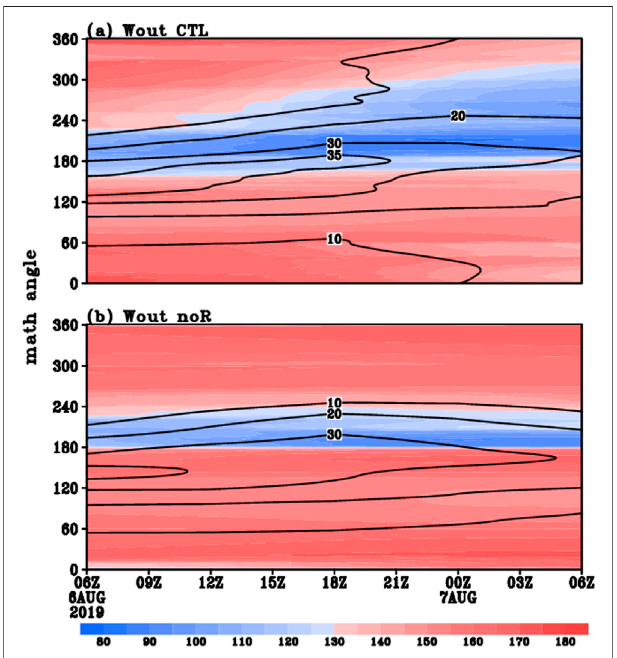
FIGURE 12 | The time revolution of the energy sinks to the idealized Carnot cycle at each azimuth in the out fl ow layer from 06 UTC 6 August to 06 UTC 7 August in (A) CTL and (B) noR. Azimuth angles are math convention, such that the azimuthal angle 0 ° is de fi ned as north (right of shear), 90 ° is de fi ned as east (down shear), 180 ° represents southward (left of shear), and 270 ° represents westward (up shear).